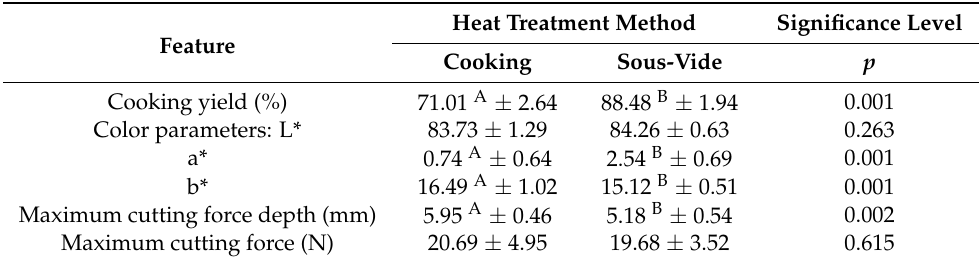
Table 3. Characteristics of meat after heat treatment (n =